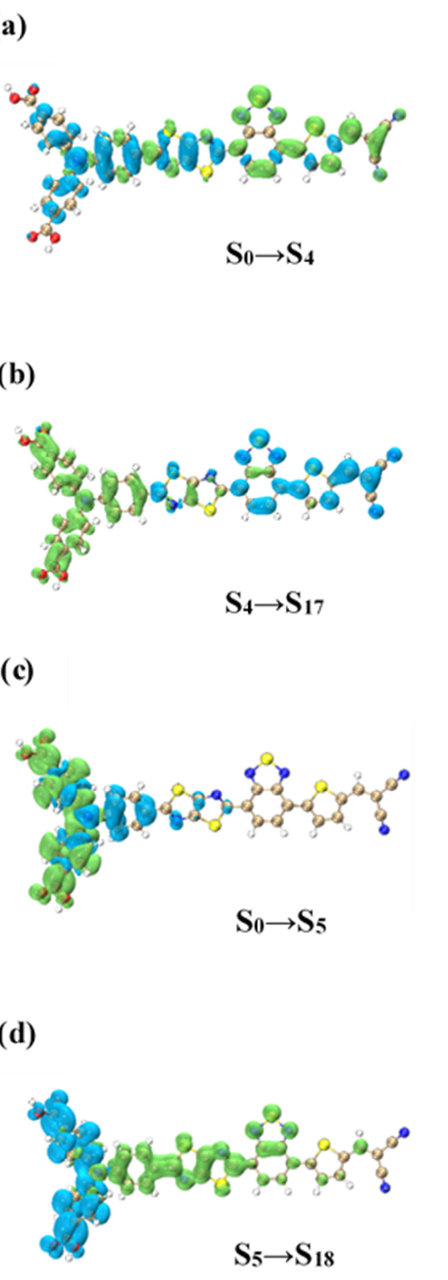
13 of 19 Figure 8. TDM and CDD of W1 in TPA. TDM and CDD of S 1 → S 14 ( a ) of W1, TDM and CDD of S 4 → S 14 ( b ) of W1, TDM and CDD of S 0 → S 9 ( c ) of W1, TDM and CDD of S 9 → S 16 ( d ) of W1. The absorption peak of WS5 was contributed to by S 17 and S 18 . First, the excitation mode of S 0 → S 4 of S 17 was analyzed. It can be seen from the TDM in Figure 9a that tri- phenylamine underwent charge transfer with the π -linker and A. There was also charge transfer between the benzene ring on the inner side of triphenylamine and the inserted D (thiazolo[5,4-d]thiazole), and the two can be considered as a whole and also underwent charge transfer with the π -linker. The CDD shows the transfer of electrons from the D to the A, which was a charge transfer excitation on the whole. As for the second step, S 4 → S 17 , it can be seen from Figure 9b that there was charge transfer between these four parts, among which the charge transfer between triphenyla- mine and the π -linker and A was relatively weak. The CDD showed a blue isosurface on the π - linker and A and a green isosurface on the triphenylamine, while the inserted D (thiazolo[5,4-d]thiazole) was blue-green, indicating that the electron transfer from the π - linker and A to thiazolo[5,4-d]thiazole and then to triphenylamine was a sequential charge